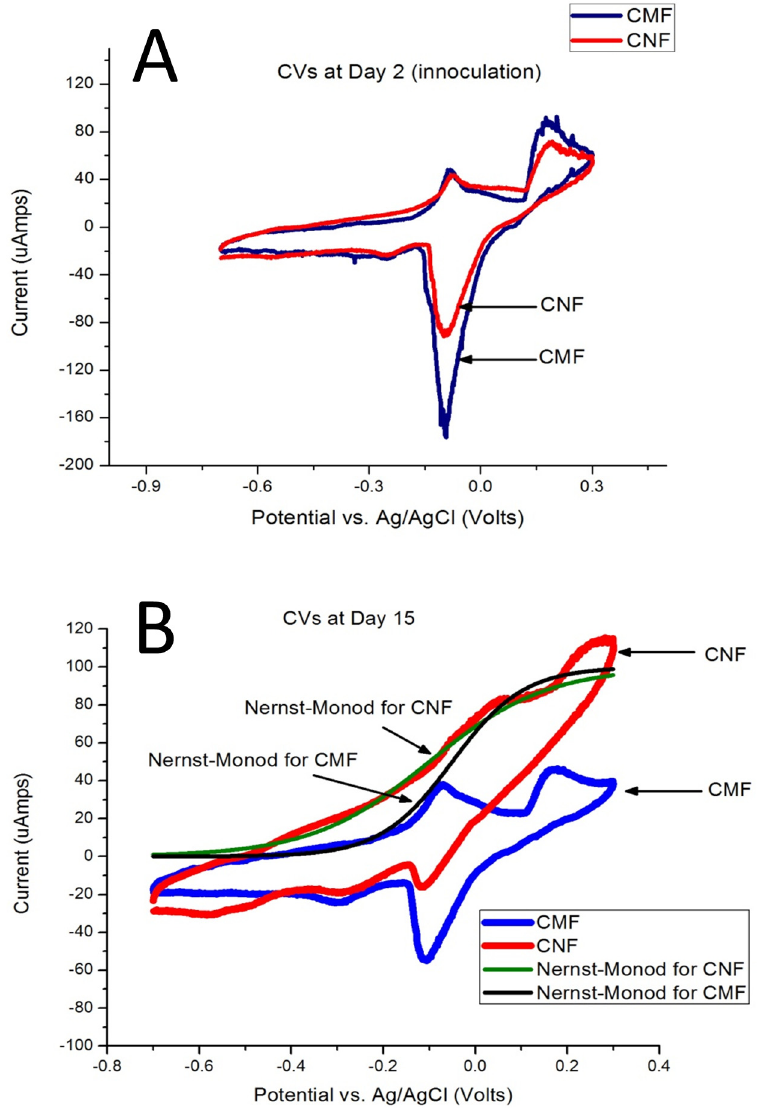
Figure 2. Cyclic voltammograms for carbon nanofiber mats/CNF (red) and carbon microfiber paper/CMF (blue) at Day 2 ( A ); and Day 15 ( B ) of the experiment. Day 15 was chosen because of the difference in current production. Electrode replacement took place after the CV. CVs were scanned from − 0.7 V to +0.3 V vs. Ag/AgCl at 2